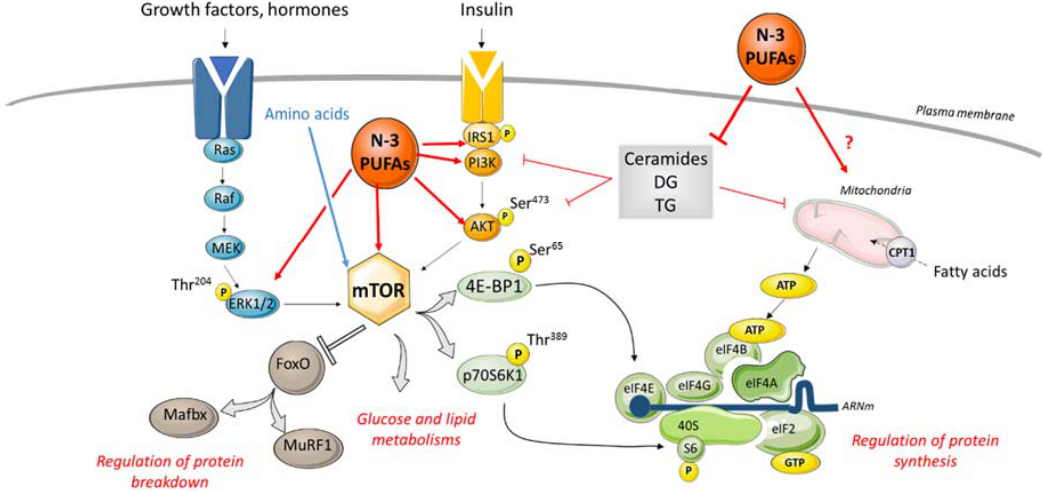
Figure 2. Modulation of muscle protein synthesis and degradation signaling by omega 3 fatty acids (FA). Several factors, such as insulin, amino acids, hormones, cytokines and growth factors can induce the activation by phosphorylation of PI3K / Akt and MAPK pathways. This leads to the activation of mTOR, which regulates glucose and lipid metabolism, activates protein synthesis and inhibits protein breakdown. Mitochondrial function is also a regulator of muscle protein synthesis by providing ATP. Muscle lipotoxicity is characterized by the accumulation of ceramides and diacylglycerols (DG) in muscles, inducing the dysregulation of protein synthesis through the inhibition of the PI3K / Akt pathway and mitochondria activity. If chronically induced, these events can lead to a decrease in skeletal muscle mass. Supplementation with omega 3 FA reduces lipotoxicity-induced muscle metabolism disorders. This e ff ect is mediated by the increased mTOR activation by PI3K / Akt and MAPK pathways and the reduction of ceramides and DG content in muscle. Thus, supplementation with omega 3 FA could improve muscle protein turnover and counteract the loss of skeletal muscle related to